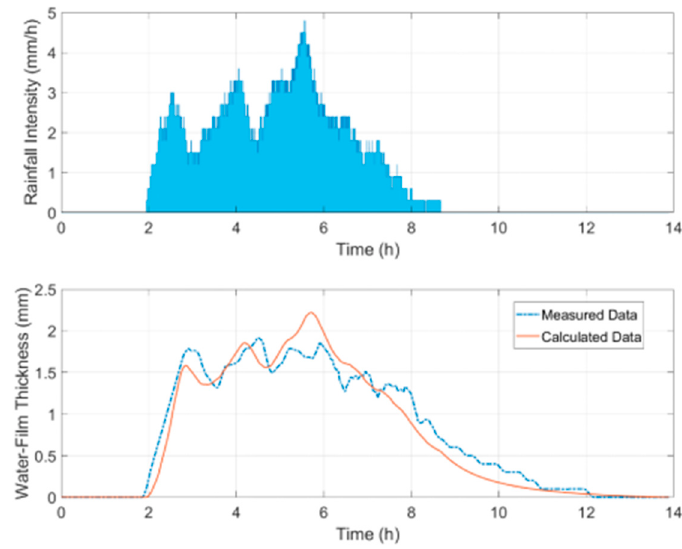
Figure 11. The validation result during a certain rainfall event.